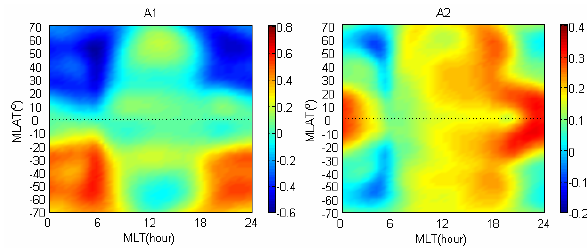
Figure 2. Annual and semiannual indices 1 A and 2 A for the year 2000 Fig. 2. Annual and semiannual indices A 1 and A 2 for the year 2000 have been estimated as functions of MLT and MLAT according to the Equation (1). In the left panel of Fig. 2, positive values indicate that the have been estimated as functions of MLT and MLAT, according to maximum value of the yearly TEC appears at the December solstice and the Eq. (1). In the left panel of Fig. 2, positive values indicate that negative denotes the June solstice. the maximum value of the yearly TEC appears at the December solstice and negative denotes the June